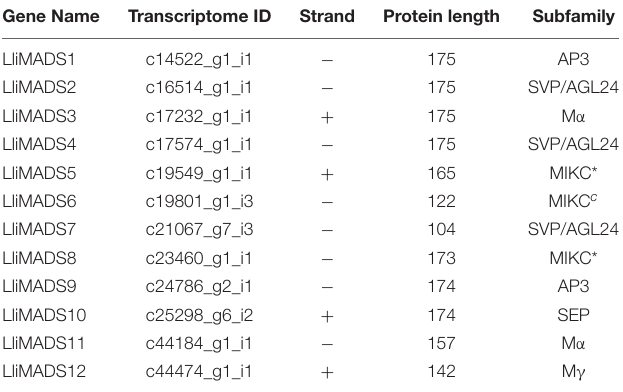
TABLE 2 | MADS-box gene names and attributes of Lumnitzera littorea